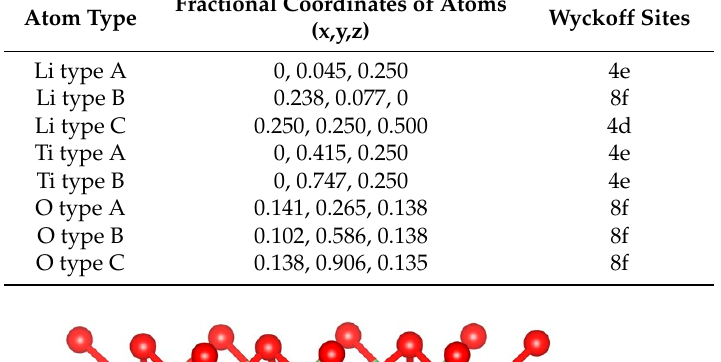
Table 1. Structure data of Li 2 TiO 3 crystal.